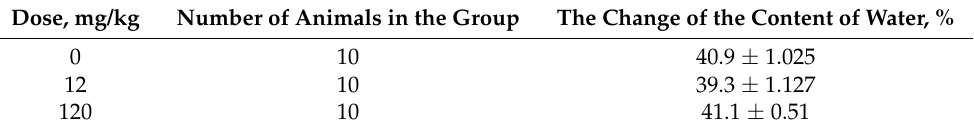
Table 2. The content of water in the small intestine in rats immunized with ovalbumin. Dose, mg/kg Number of Animals in the Group The Change of the Content of Water, %